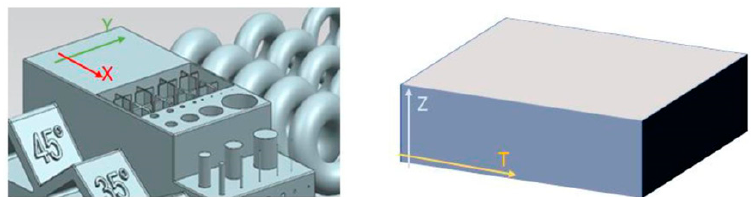
Figure 4. Surface roughness measurements of samples with spiral and big parallelepiped. ( left ) position on the sample with spirals where the roughness in X and Y directions was measured, ( right ) position on the parallelepiped where the roughness in Z and T directions was measured.